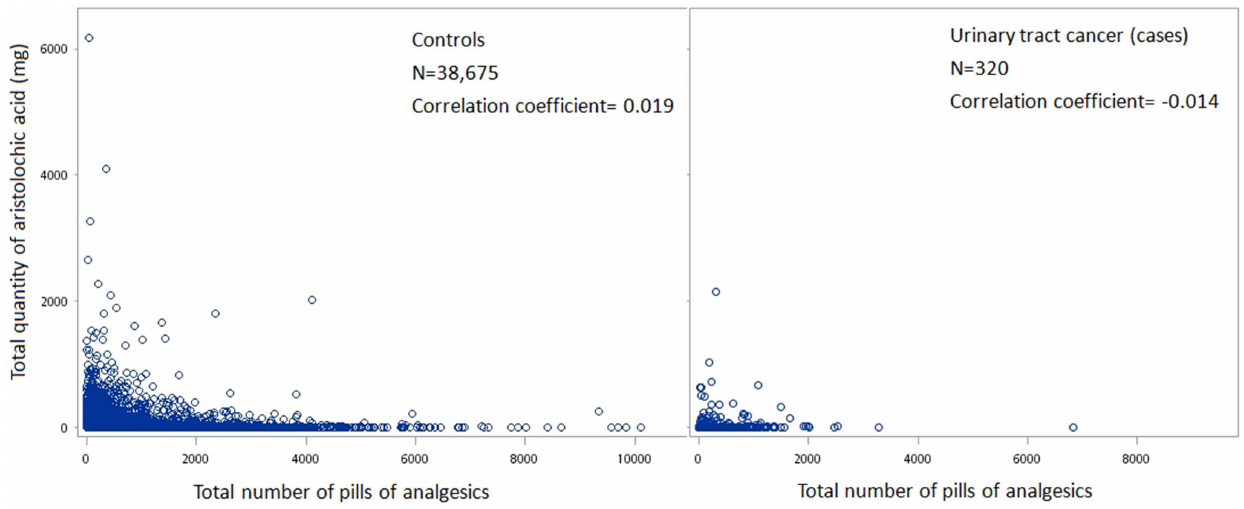
All ESRD Patients